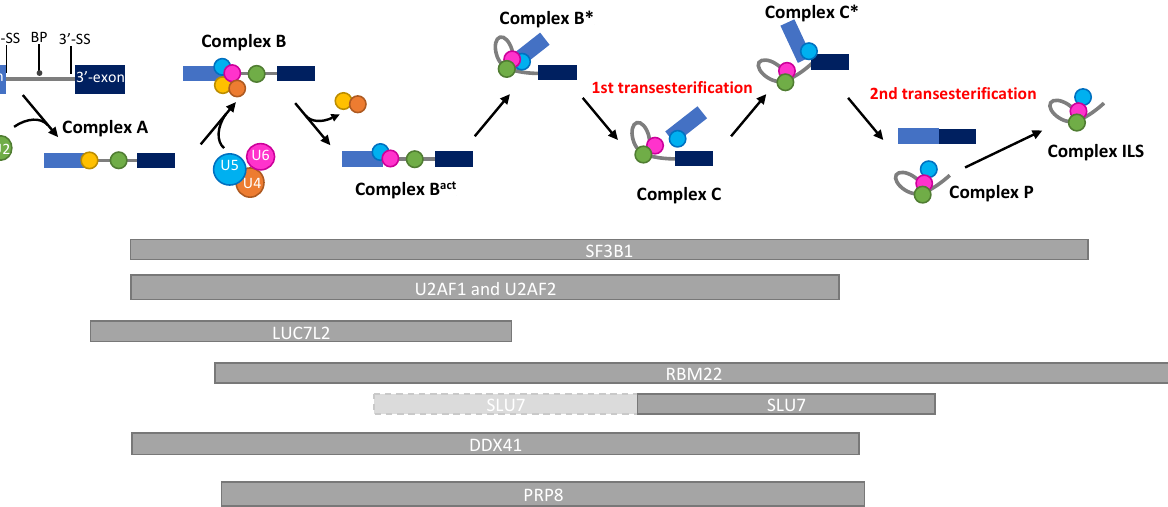
Figure 2. Schematic representation of the kinetics of the presence of splicing factors during a pre ‐ mRNA splicing reaction. RNA splicing is a process by which introns are removed from pre ‐ mRNAs, and exons are ligated to produce a mature mRNA. By the action of more than 200 proteins and 6 ribonucleoprotein complexes (U1 ‐ U6), the intron will be separated from the 5 ′‐ exon (1st transesterification) and, subsequently, from the 3 ′‐ exon (2nd transesterification), allowing the ligation of both exons. This reaction depends on the recognition of consensus splicing sequences (5 ′‐ Splice site, Branch point, 3 ′‐ Splice site) by the spliceosome. The 5 ′ and 3 ′ exons are represented with light and dark blue boxes, respectively. The U1, U2, U4, U5, and U6 ‐ snRNA are, respectively, represented with yellow, green, orange, blue, and pink circles. The kinetics of presence of the proteins discussed in this review are represented by grey bars below the reaction timeline. Light ‐ grey bars with a dashed border line represent a low affinity presence. BP: Branch Point; 5 ′‐ SS: 5 ′‐ Splice site; 3 ′‐ SS: 3 ′‐ Splice site.